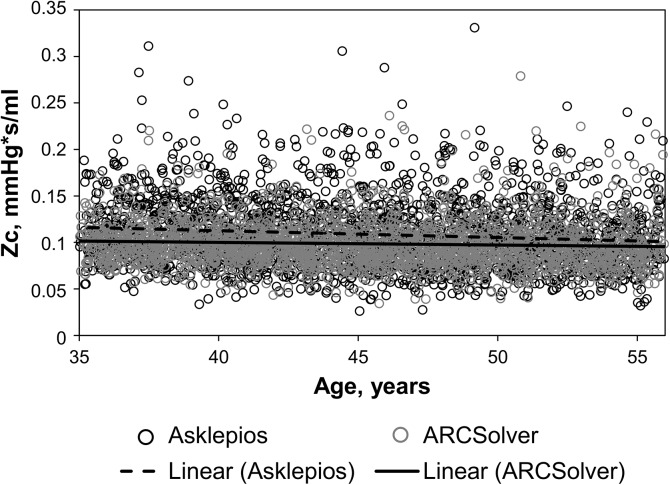
Characteristic impedance Zc over age.